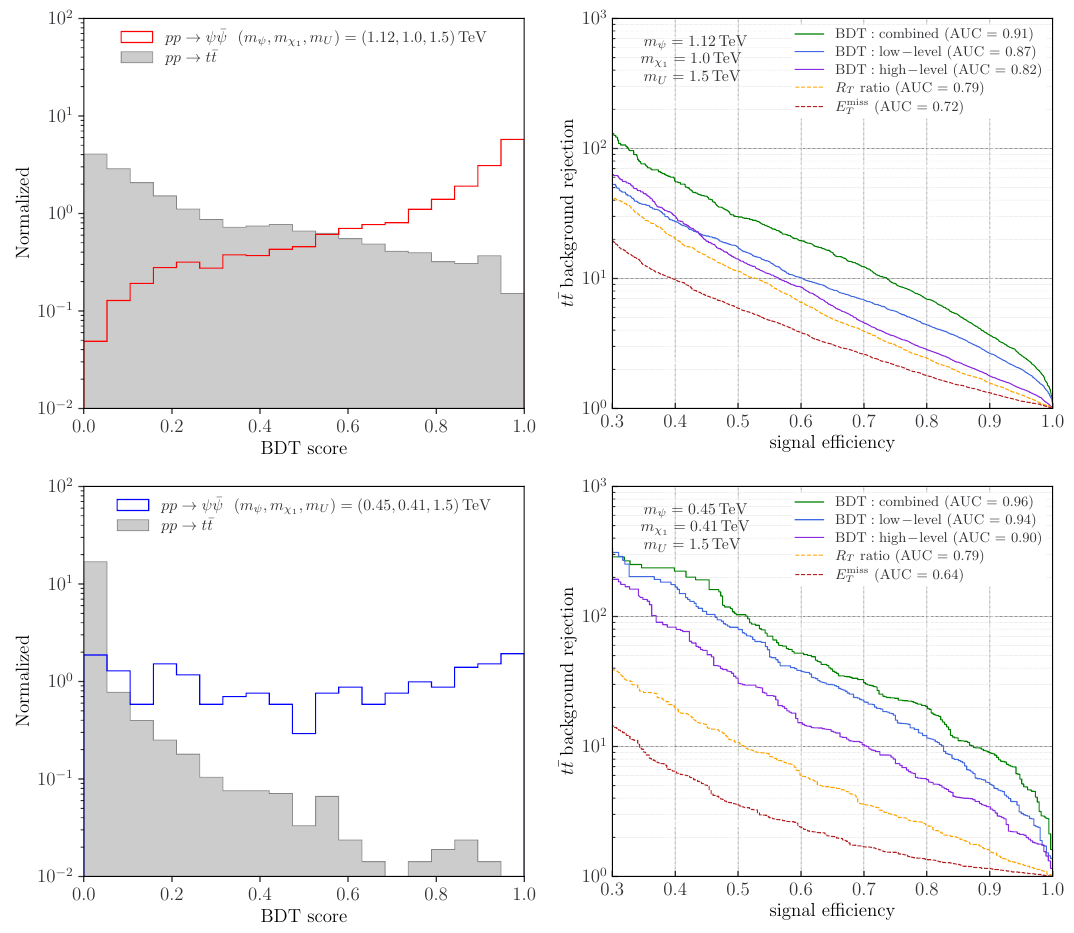
Figure 6 . Left panels: BDT scores for the two different benchmark points showing signal vs background discrimination. Right panels: ROC curves for the same benchmarks showing the t ¯ t background rejection rate vs signal efficiency for three different BDT classifiers based on only high- level observables (purple curve), low-level observables (blue curve) and both high-level and low-level observables (green curve). For comparison, we also include the cut-based ROC curves for the R T ratio (dashed yellow) and E miss (dashed red). Better performance is achieved by ROC curves T stretching towards the upper-right corner and AUC values closer to 1